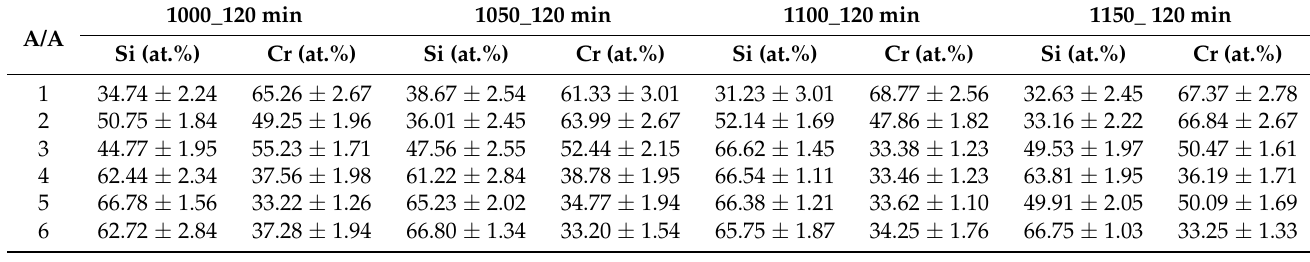
Table 2. EDS scannings of the chromized samples obtained by 40 wt.% Cr in the pack mixture for 120 min at various temperatures.